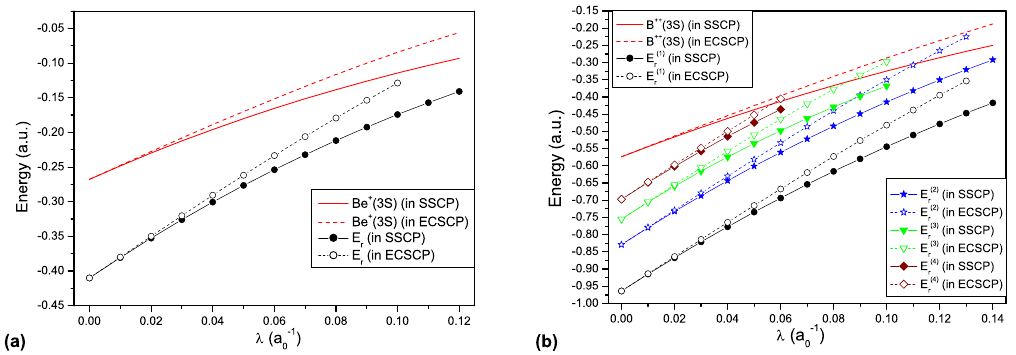
Figure 3. Resonance energies E r as a function of the screening parameter λ . ( a ) Be, ( b ) B + . Table 4. Energies (in a.u.) and widths (in a.u.) of the DESs of the Be-like ions in SSCP and ECSCP lying above the 1 s 2 2 p threshold for various values of the screening parameter ( λ ) (in a − 1 measured relative to the energy of the corresponding core. Rows corresponding to a and b denote the results for SSCP and ECSCP,